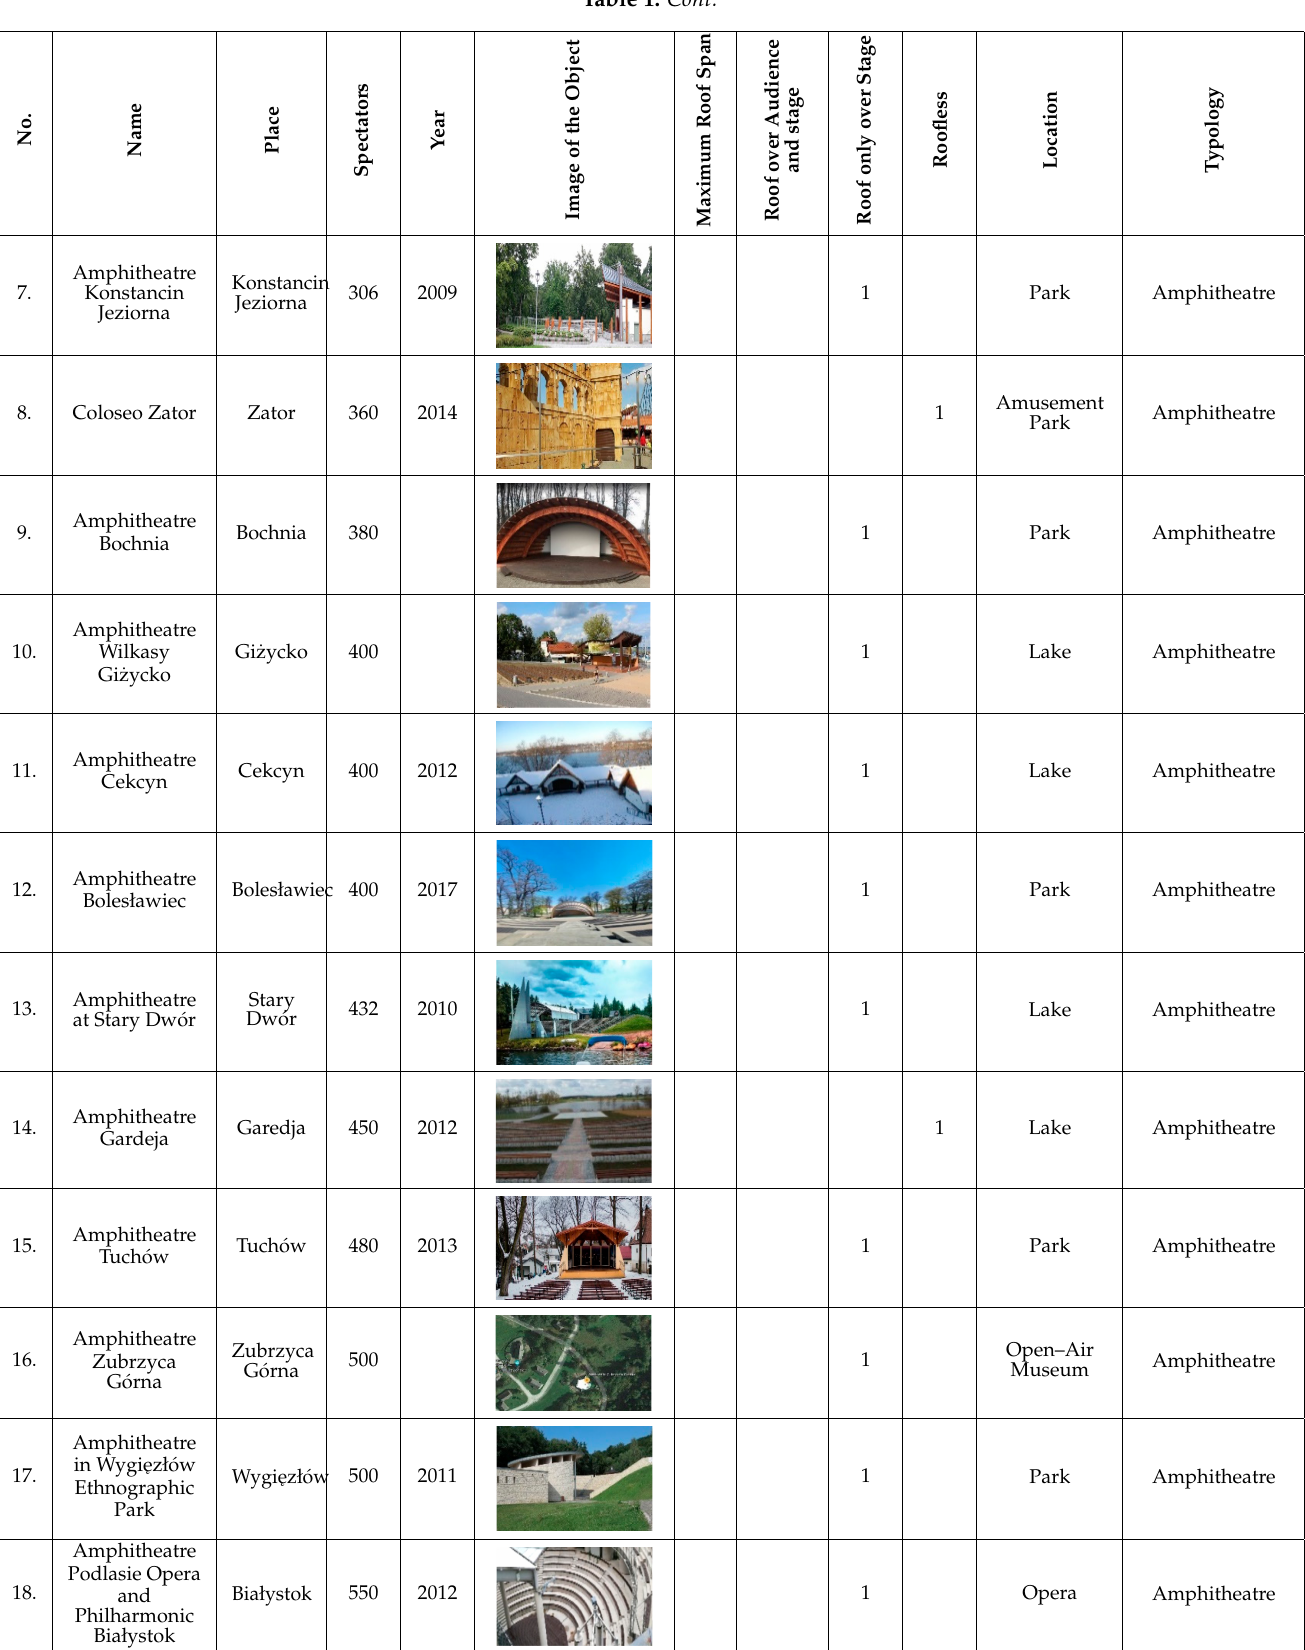
Table 1. Fifty-seven amphitheaters in Poland ordered by number of spectators. Number 1 in the cell means that the de- scribed factor exists. Author’s research. Amphitheaters are shown on the map in Figure 5 following the numbers in column